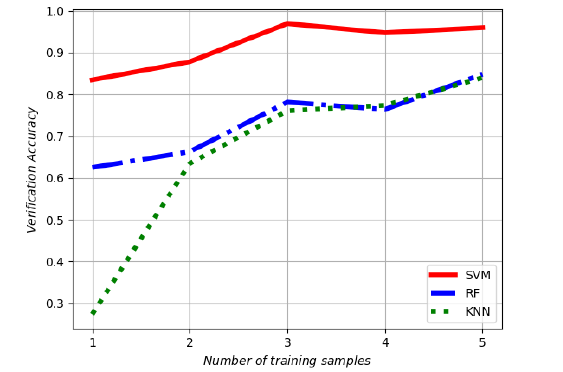
Figure 15. Accuracy curves of SVM, RF, and KNN classifiers in the IITD touchless